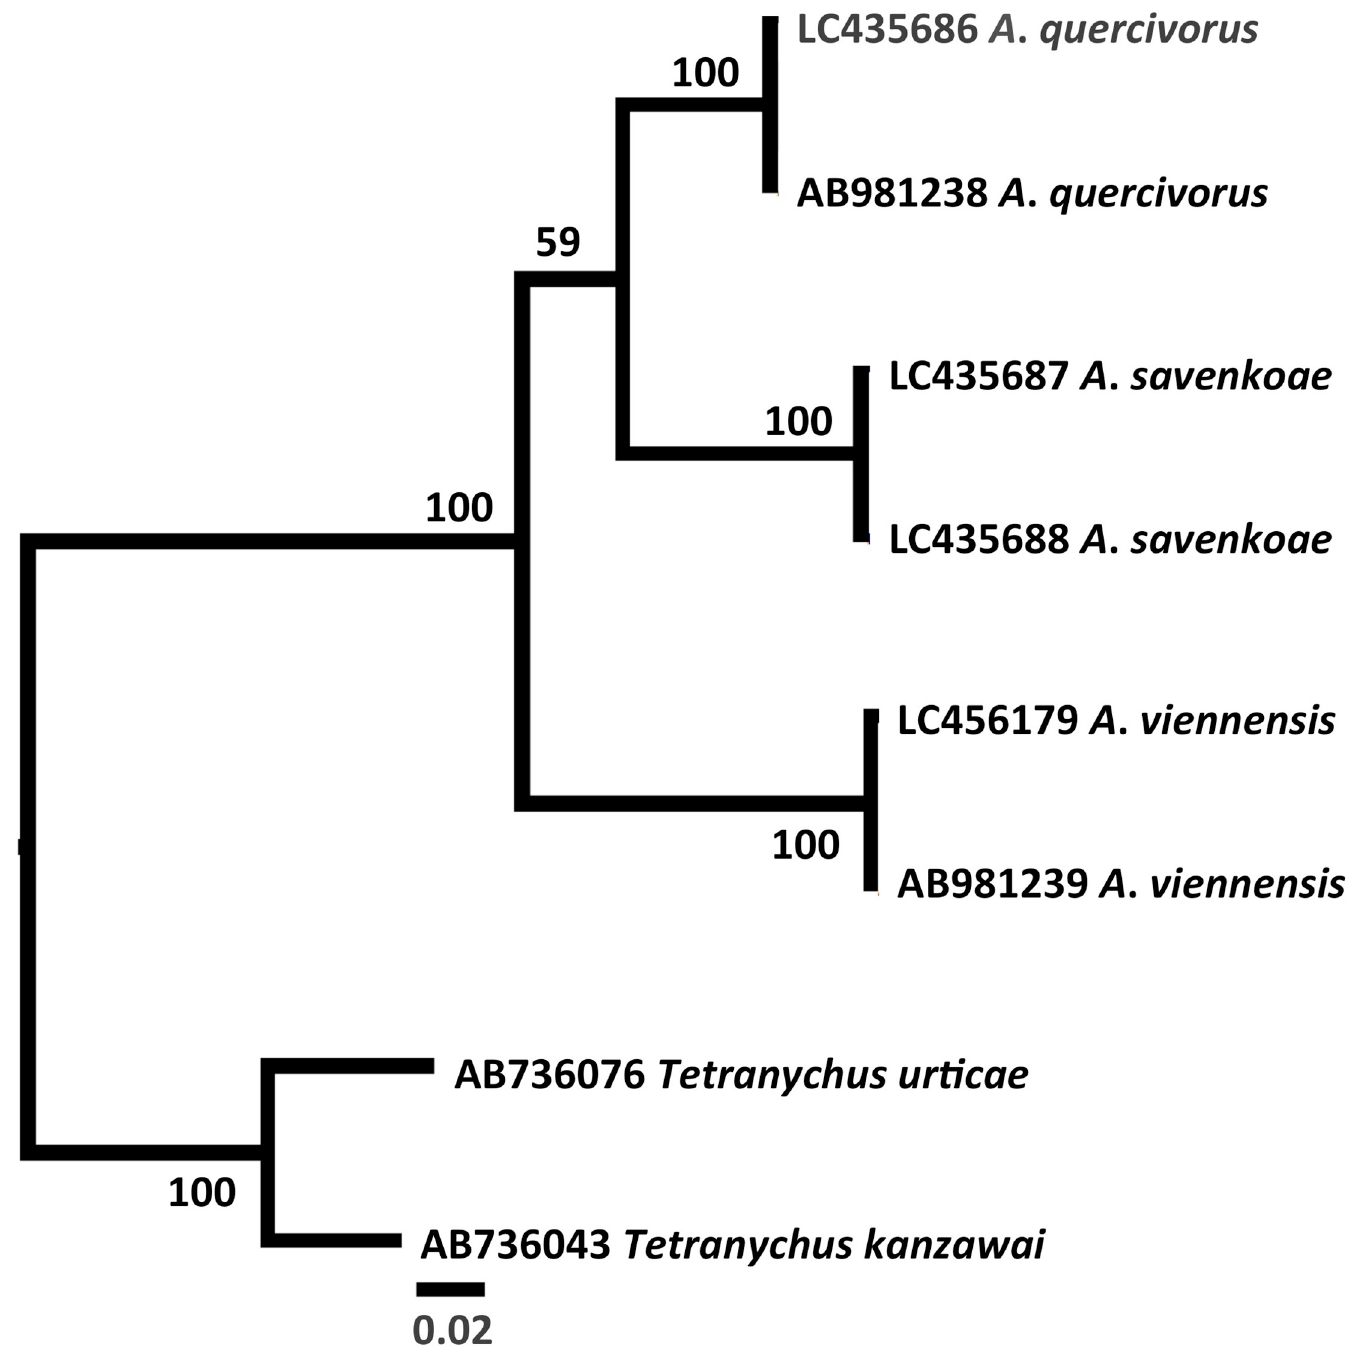
Fig 11. Maximum likelihood tree based on 618 bp of the mitochondrial COI gene of the genus Amphitetranychus using the GTR+G model. Bootstrap values based on 100 replications are indicated at the nodes. Only bootstrap values > 50% are shown. Each operational taxonomic unit is indicated by accession number and scientific